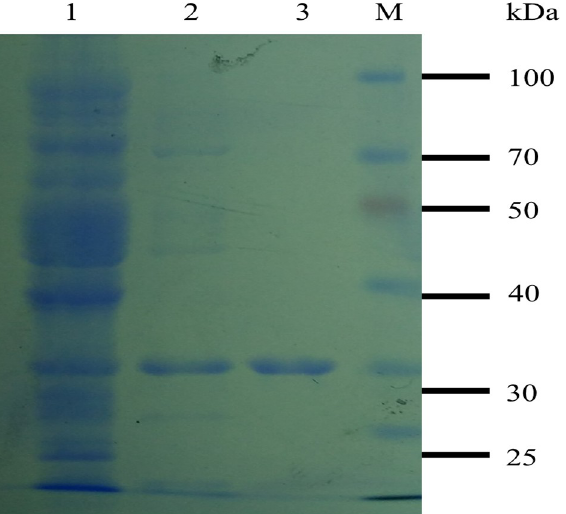
Fig 5. Purified TAT-HuScFv. Lane M: marker; lane 1: ultrasonic supernatant induced by TAT-HuScFv expression bacteria; lane 2: Cu 2+ 200 mmol imidazole eluted sample; lane 3: purified TAT-HuScFv.